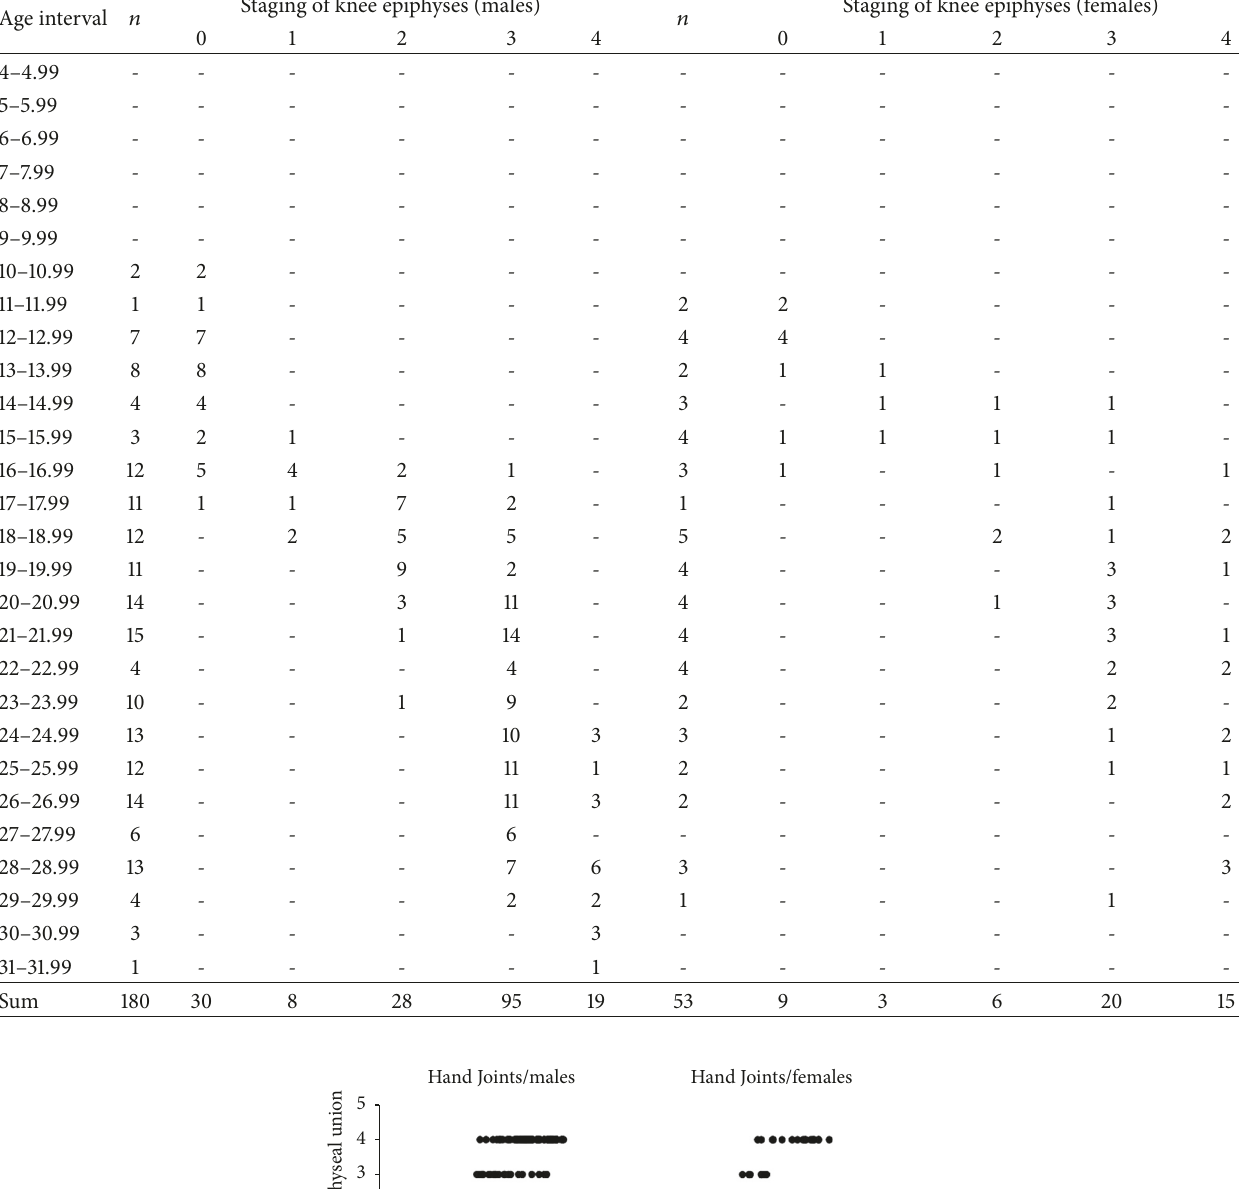
Table 1: Numbers of images at each stage of epiphyseal union of the knee joint bones.